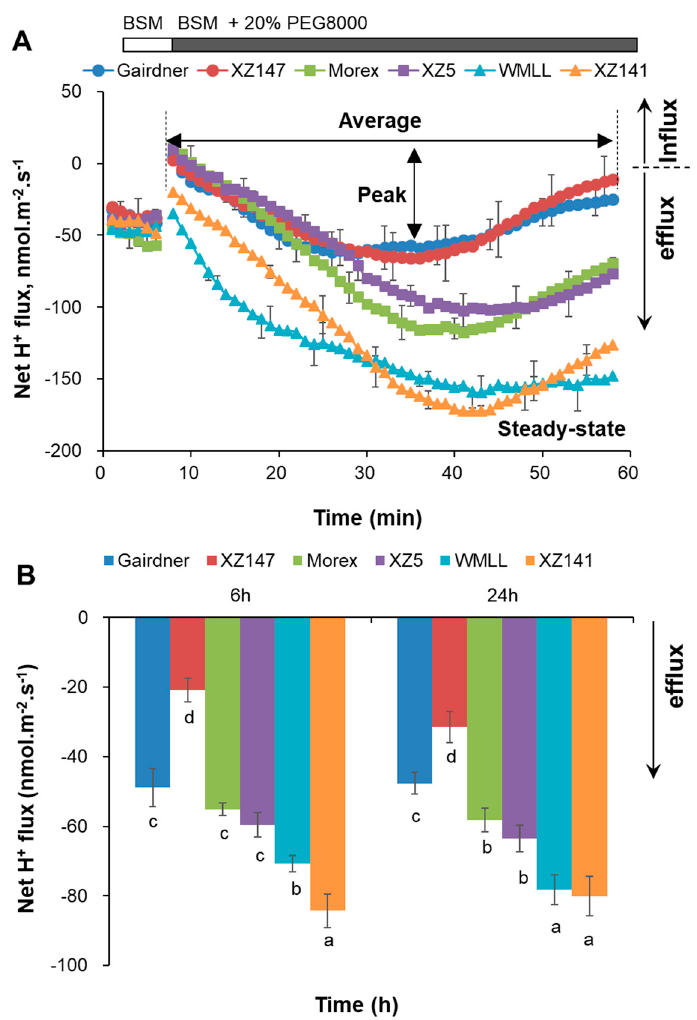
Figure 7. Transient ( A ) and steady-state ( B ) net H + flux response to drought stress generated by 20% PEG8000 measured from mature ( ∼ 20 mm from root tip) zones of six barley varieties contrasting in drought stress tolerance. Data are mean ± SE ( n = 6 individual plants). The onset of treatment is indicated by an arrow. Measurements were undertaken at room temperature (24 ± 1 °C). Different lowercase letters indicate the significant difference between genotypes at p < 0.01.